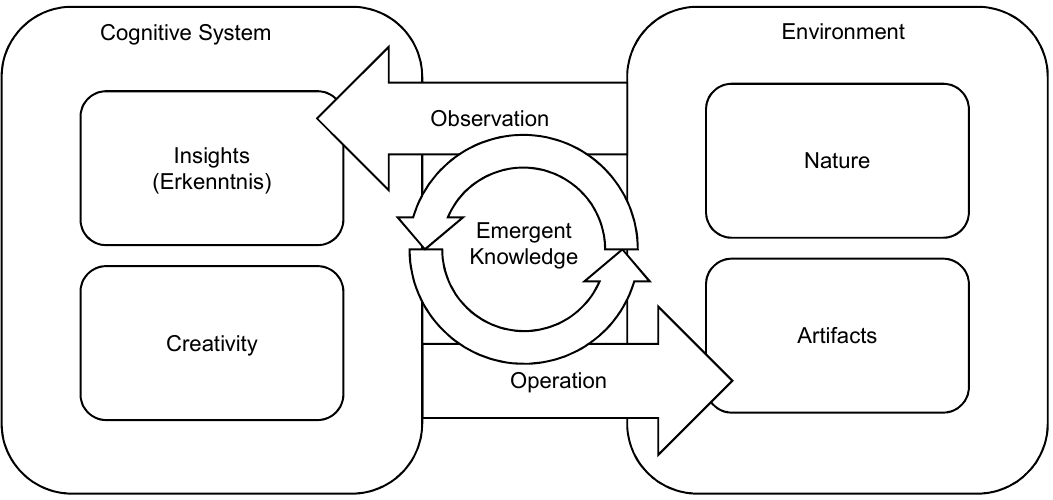
Figure 2. Epistemology of cognitive systems according to Luhmann: A constructivist operational theory of emergent knowledge